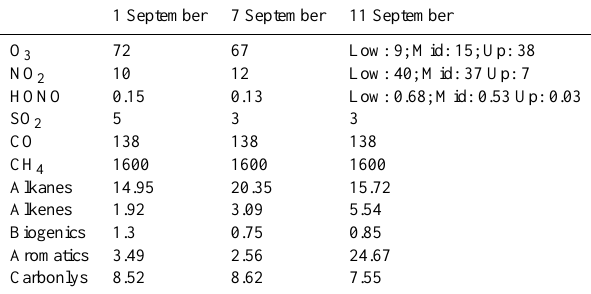
Table 2. Initial concentrations in ppb for model